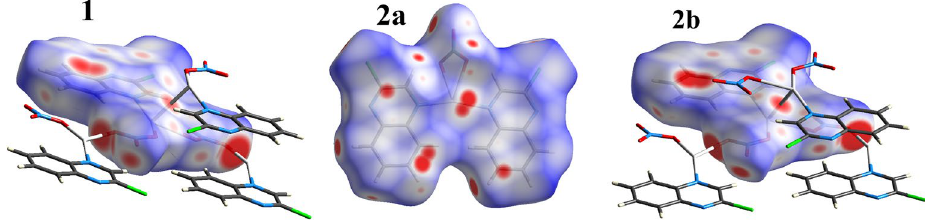
Figure 13. Hirshfeld d norm maps reveal the polymeric nature of 1 and 2b and the monomeric form of 2a